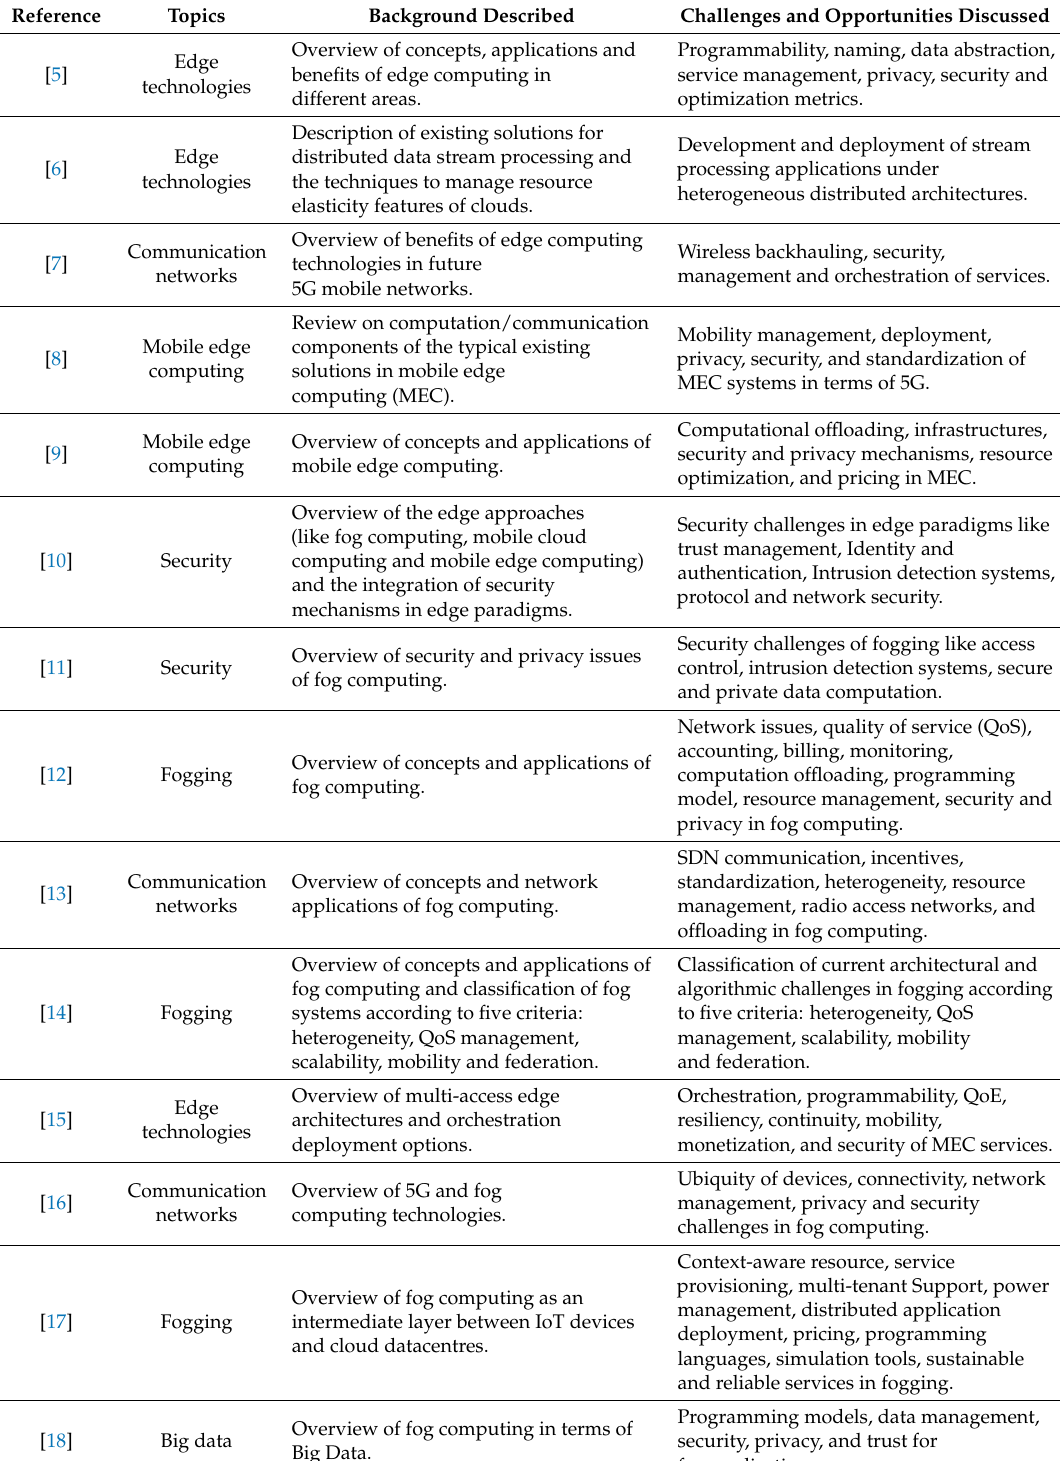
Table 1. Related surveys on edge